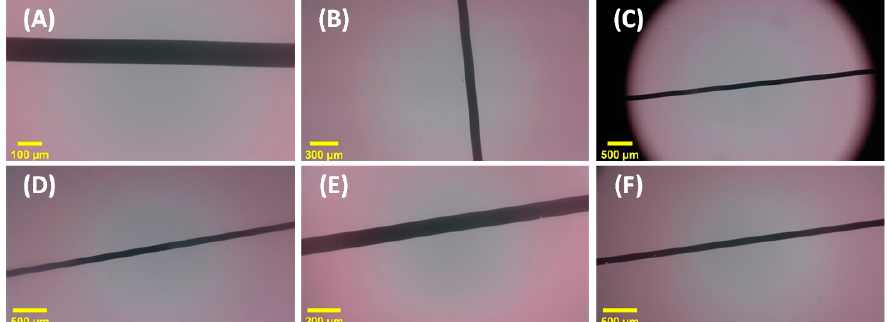
Figure 3. Photos of 100 um wide line target obtained by the tube lens (EFL = 6 mm) matched with different cell phone camera lenses. ( A – F ) The pictures correspond to different object lenses in turn, which are LG G5 super wide ‐ angle lens, P20pro wide ‐ angle lens, P20pro tele ‐ photo lens, P20pro standard lens, Mate20 wide ‐ angle lens and Mate20 standard lens. The imaging test results of the six dismantled lenses are shown in Figure 3. The mag ‐ nification ratio can be determined according to the line width (in pixels) in the image, the pixel size on the sensor and the nominal line width of the sample. The focal length of the